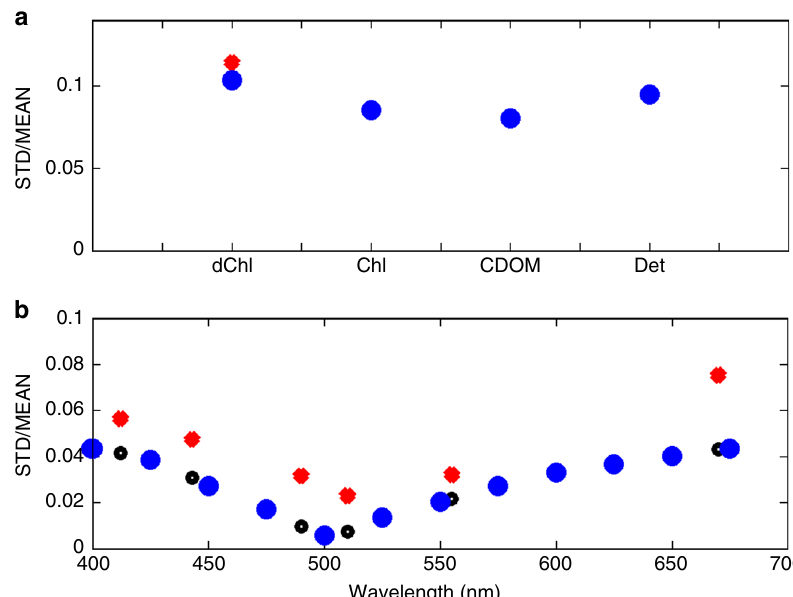
Fig. 3 Relative magnitude of interannual variability. Global median of the ratio of the annual composite temporal standard deviation to the 18 year mean composite for a satellite derived Chl-a (dChl), actual Chl-a (Chl), detrital matter (det) and CDOM; and for b remotely sensed re fl ectance. Blue indicates model output, red for OC-CCI products, and black for the model interpolated to the OC-CCI wavebands. The OC-CCI re fl ectances are at 412, 443, 490, 510, 555, 670 nm. See Supplementary Fig. 4 for spatial patterns of relative magnitude or both model of OC-CCI products